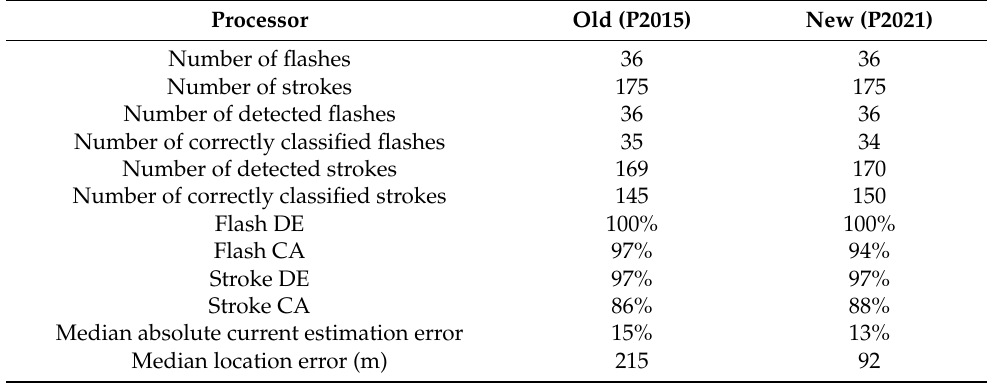
Table 3. Summary of performance characteristics of P2015 and P2021 evaluated using rocket- triggered